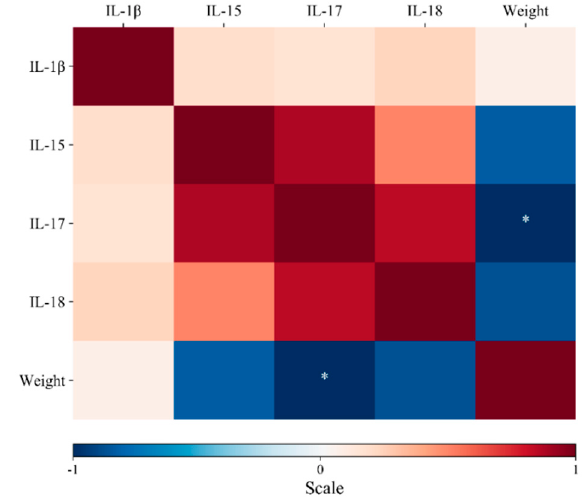
Figure 2. Heat map representing Pearson’s r correlation coefficient matrix among the indicators. Scores are denoted in color from -1 (blue) to 1 (red). * Indicates significant differences (Tukey’s test, p < 0.05). The negative value of the coefficient implies that IL-17 and body weight are inversely related; in other words, when this cytokine is upregulated, a loss in body weight might be expected.